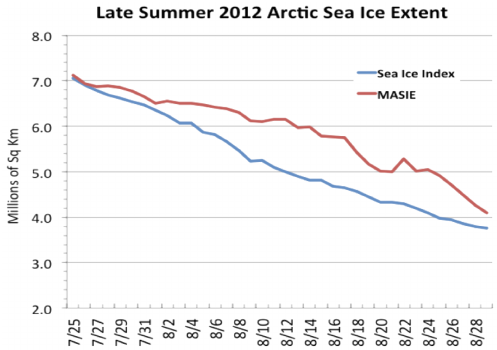
Figure 2. Arctic sea ice extent (million km 2 ) calculated using passive microwave data (blue) and the Multisensor Analyzed Sea Ice Extent (MASIE) product (red) for 25 July–28 August 2012. The passive microwave data are from the SSMIS on board the DMSP F17